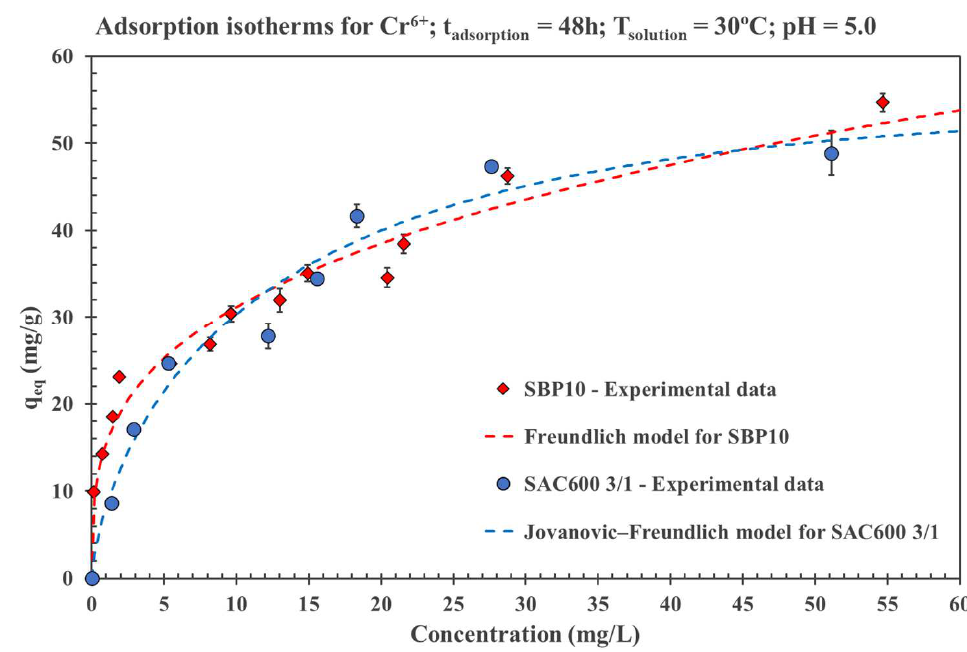
Figure 6. Adsorption isotherms for SAC600 3/1 and SBP10.